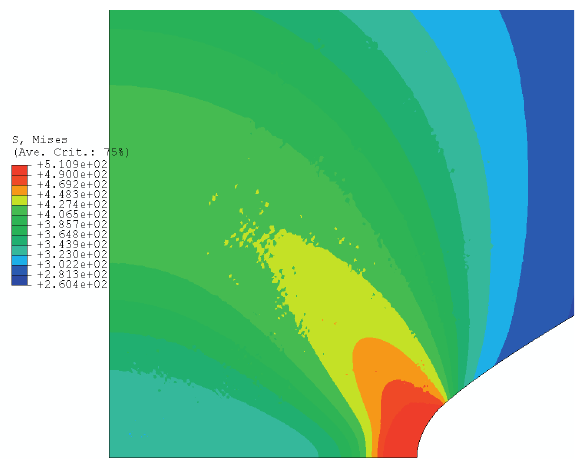
Figure 12(b). Von Mises stress.Stress contours in the notched region for 22N steel at 823 K. Nominal stress D 431 MPa.